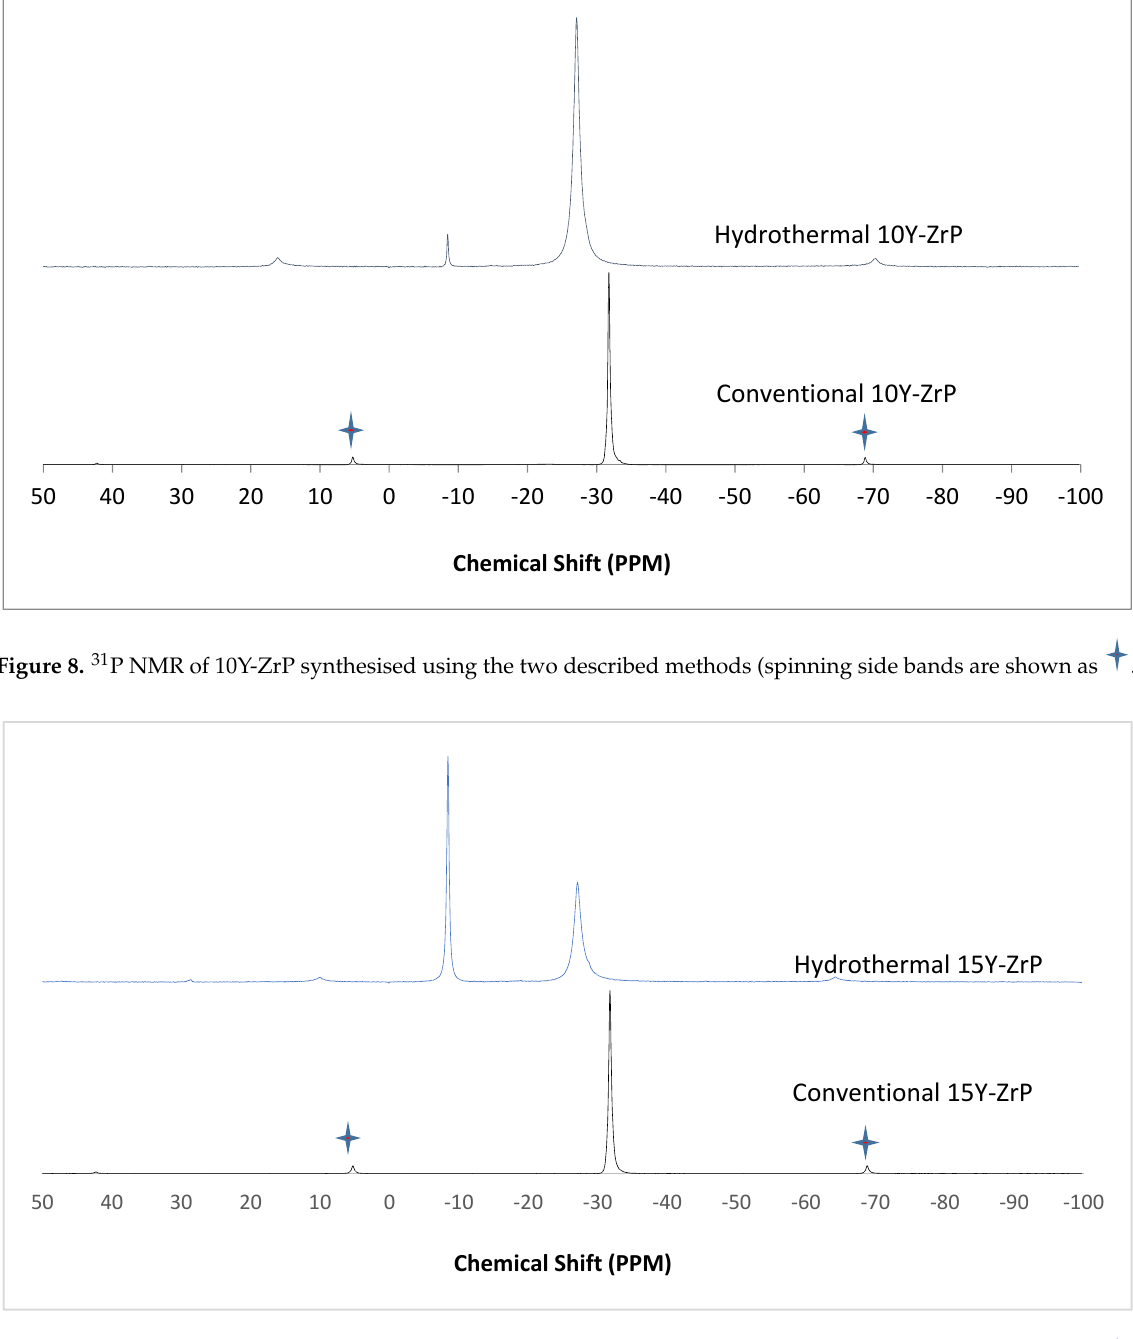
Figure 6. 31 P NMR of α -ZrP synthesised using the two described methods (spinning side bands are shown as ).